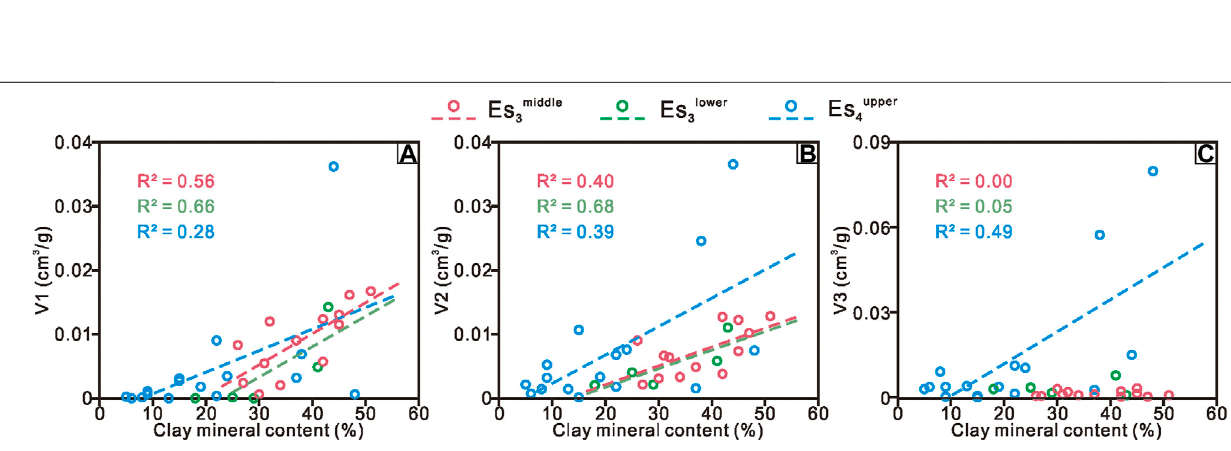
Frontiers in Earth Science |